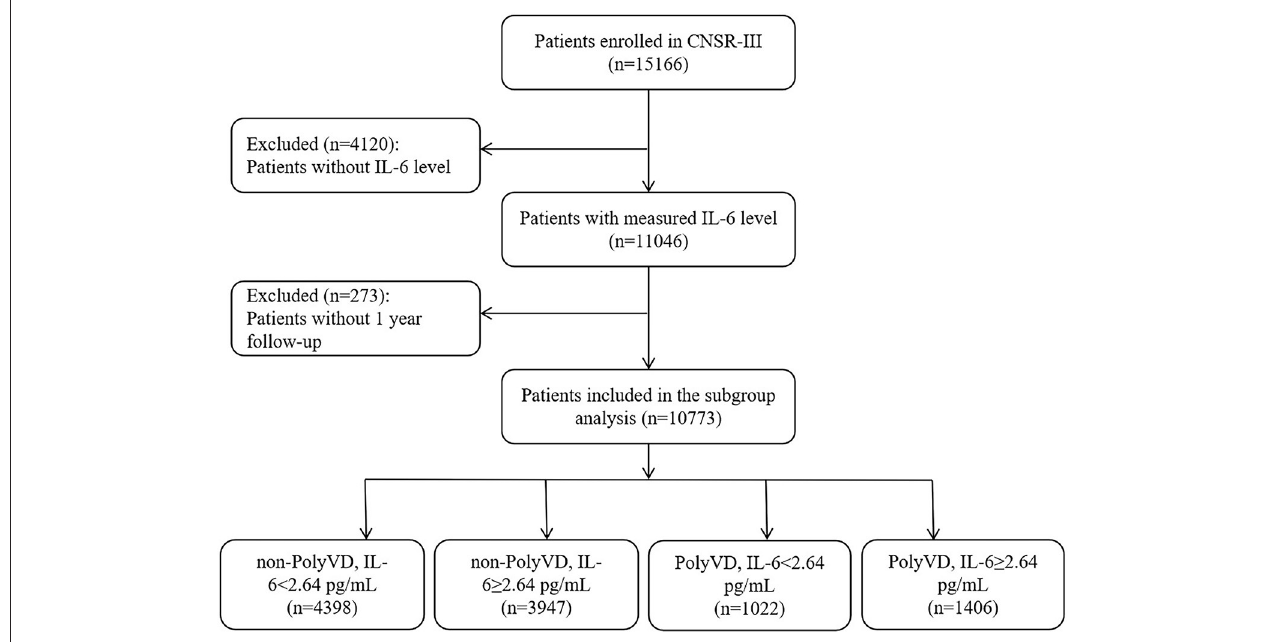
FIGURE 1 | Patient flow diagram. CNSR-III, China National Stroke Registry III; IL-6, interleukin-6; PolyVD, polyvascular disease.